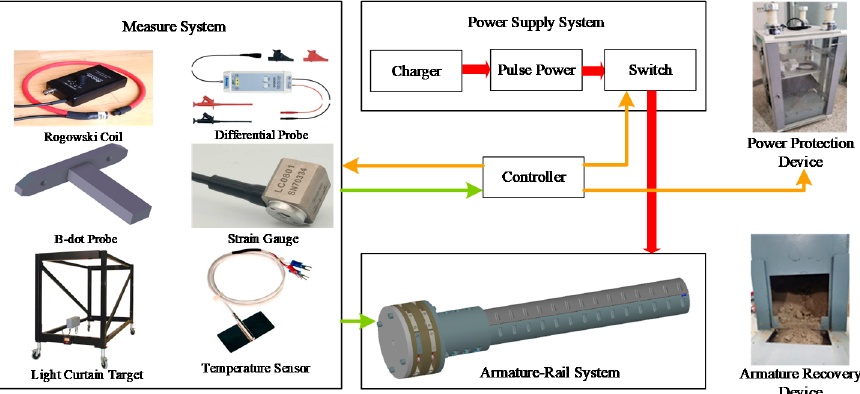
Figure 16. Schematic diagram of the test platform. A physical view of the launcher test platform is shown in Figure